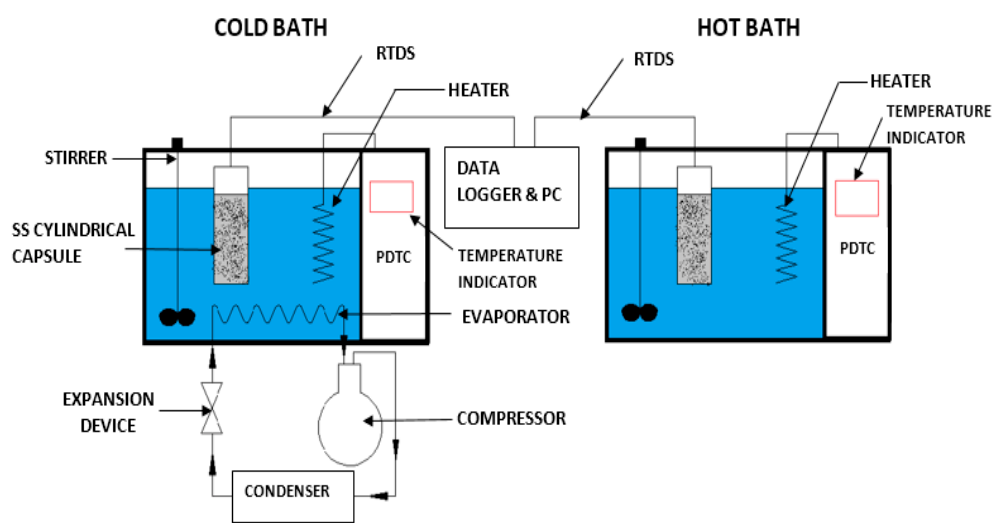
Figure 3. Experimental setup for the freezing/melting study.